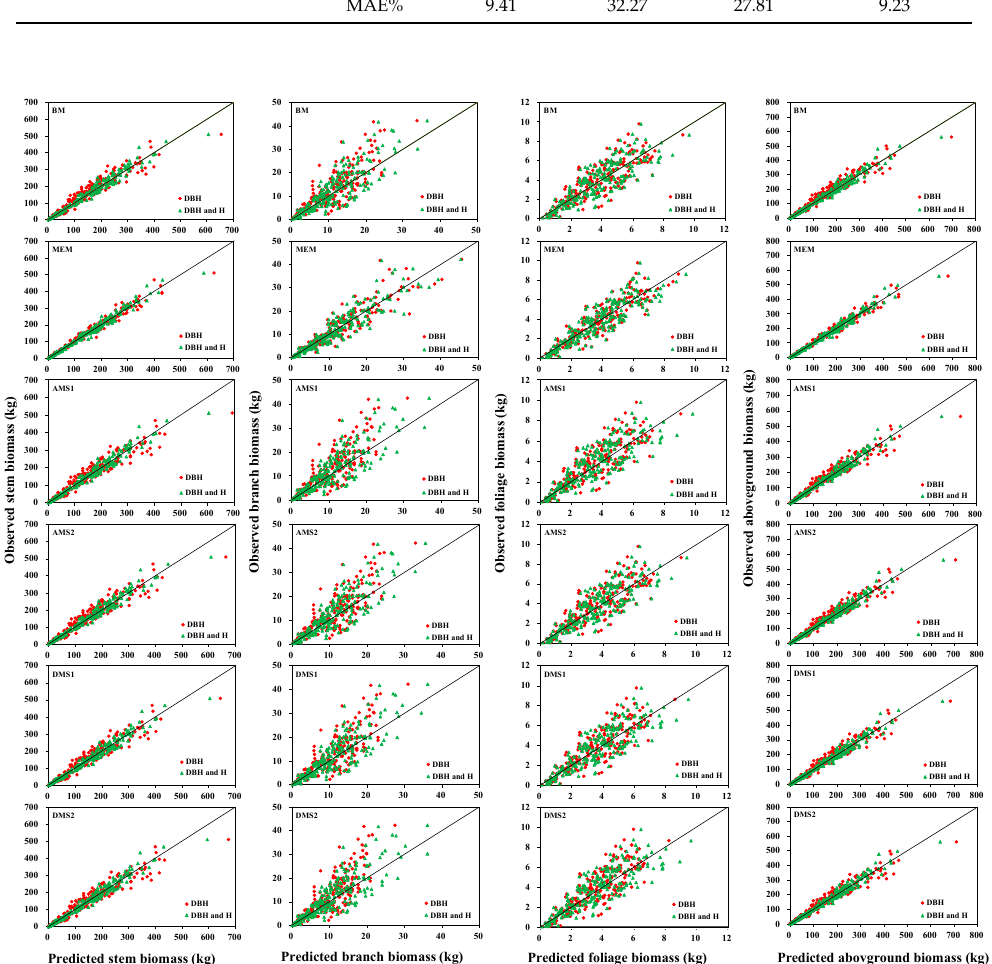
Figure 3. The observed data and model predictions from the six biomass modeling approaches based on 𝐷𝐵𝐻 and combination of 𝐷𝐵𝐻 and 𝐻 for stem, branch, foliage, and aboveground biomass.